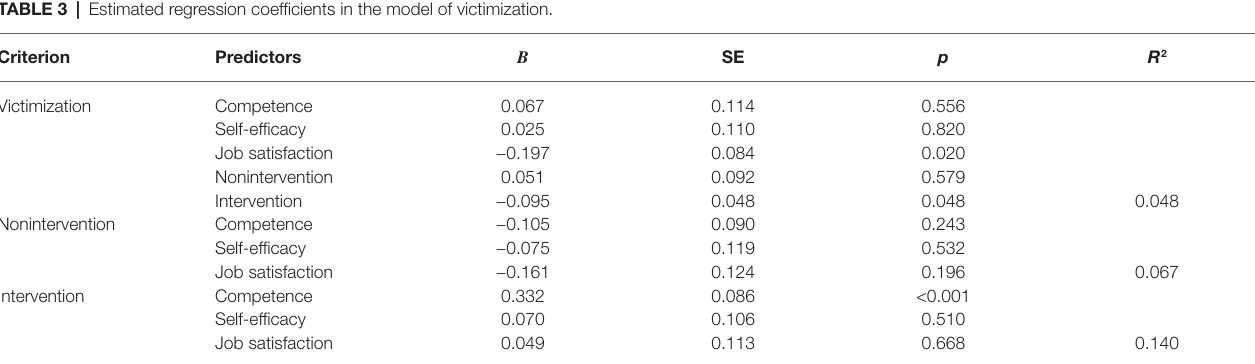
TABLE 3 | Estimated regression coefficients in the model of